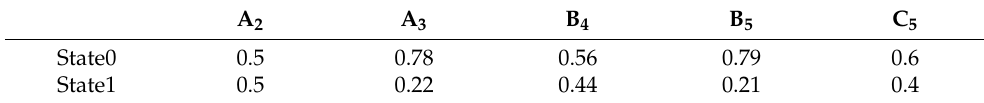
Table 6. Probability of five root nodes.